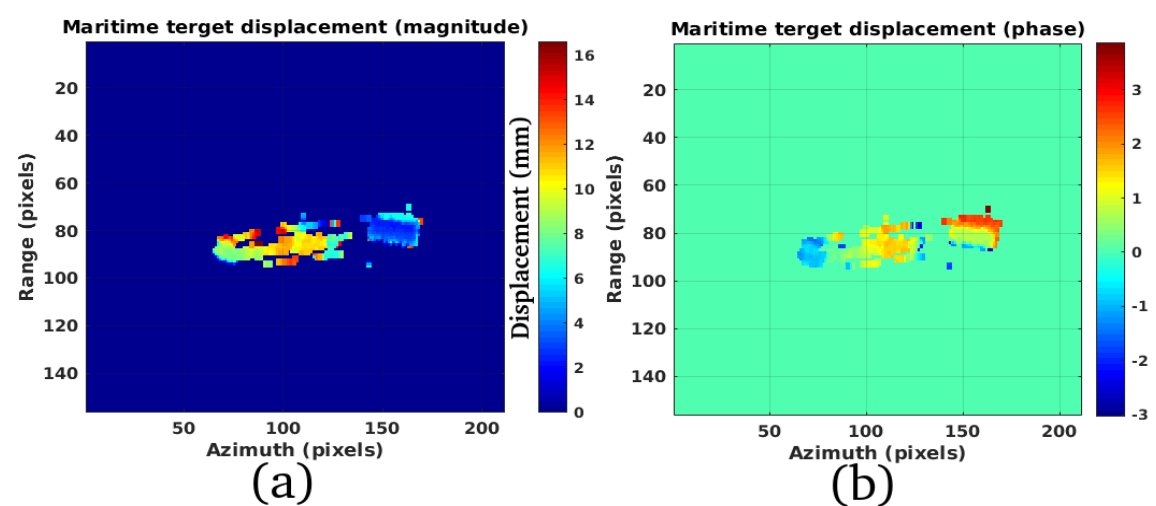
Figure 25. ( a ): Large ship displacement map (magnitude). ( b ): Large ship displacement map (phase).